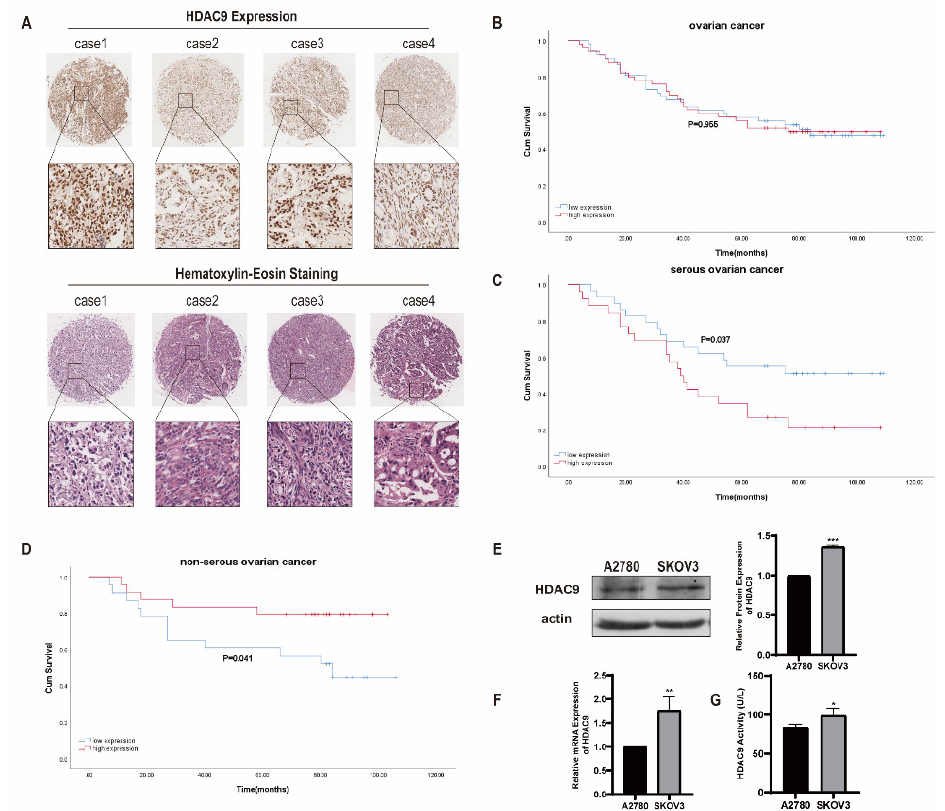
Figure 1. Expression of histone deacetylase 9 (HDAC9) in human ovarian cancer tissues and cell lines. ( A ) Immunohistochemical staining of HDAC9 and hematoxylin–eosin staining in ovarian cancer tissue microarrays (40×). Typical staining is shown in the adjacent rows (200×). ( B ) Kaplan–Meier survival curve shows an insignificant correlation between HDAC9 expression and survival rate in human ovarian cancer ( p = 0.955). ( C ) Kaplan–Meier survival curve shows a significant correlation between high HDAC9 expression and low survival rate in human serous ovarian cancer ( p = 0.037). ( D ) Kaplan–Meier survival curve shows a significant correlation between low HDAC9 expression and low survival rate in human non-serous ovarian cancer ( p = 0.041). ( E ) The protein expression of HDAC9 was measured by Western blot (means ± SD, n = 3, *** p < 0.001). ( F ) Relative HDAC9 expression was measured by qRT-PCR (means ± SD, n = 3, ** p < 0.01). ( G ) HDAC9 activity was measured by ELISA (means ± SD, n = 3, * p < 0.05).